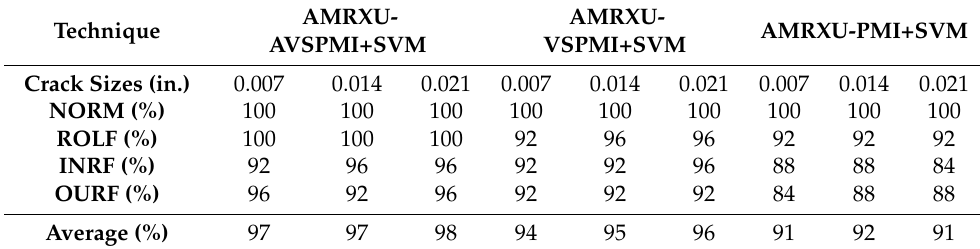
Table 7. The accuracy of state identification (torque load: 2 hp).